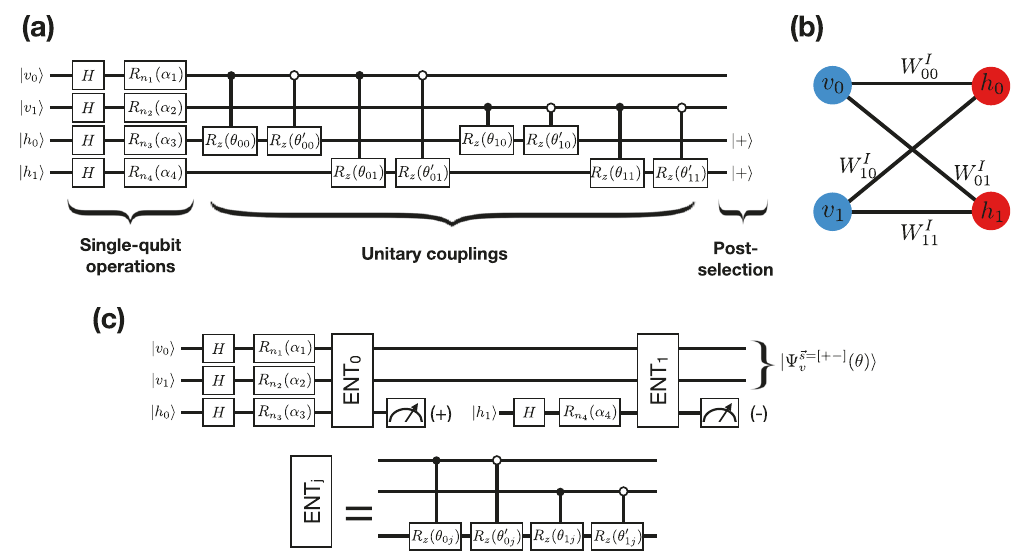
¼ (cid:3) θ ij . b Schematic ij